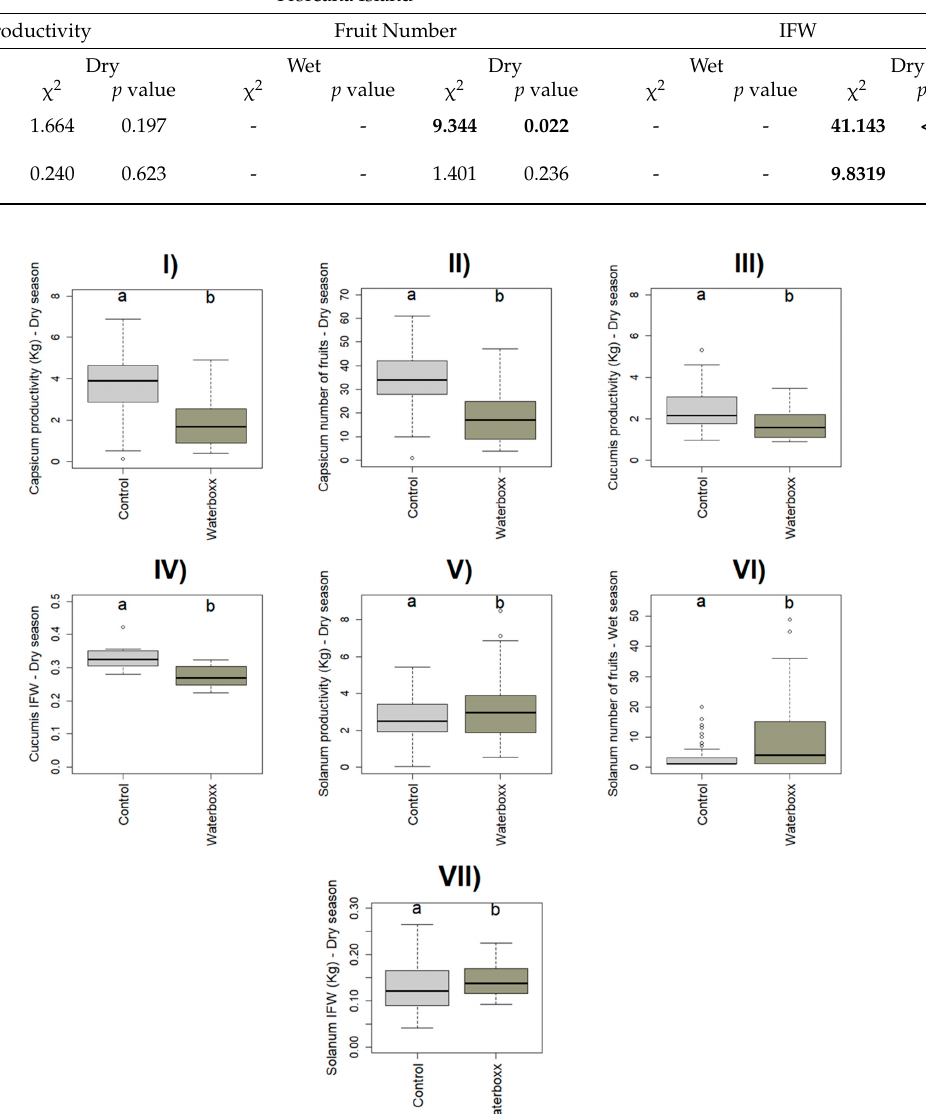
Figure 1. Significant effect of WST on crop’s plant traits from Santa Cruz represented by boxplot, showing the data distribution with maximum and minimum values, lower and upper quartiles, the median and outliers represented by dots outside the boxplot (same for Figures 2–4). Capsicum: ( I ) Productivity-dry season, ( II ) Number of fruits—dry season; Cucumis: ( III ) Productivity—dry